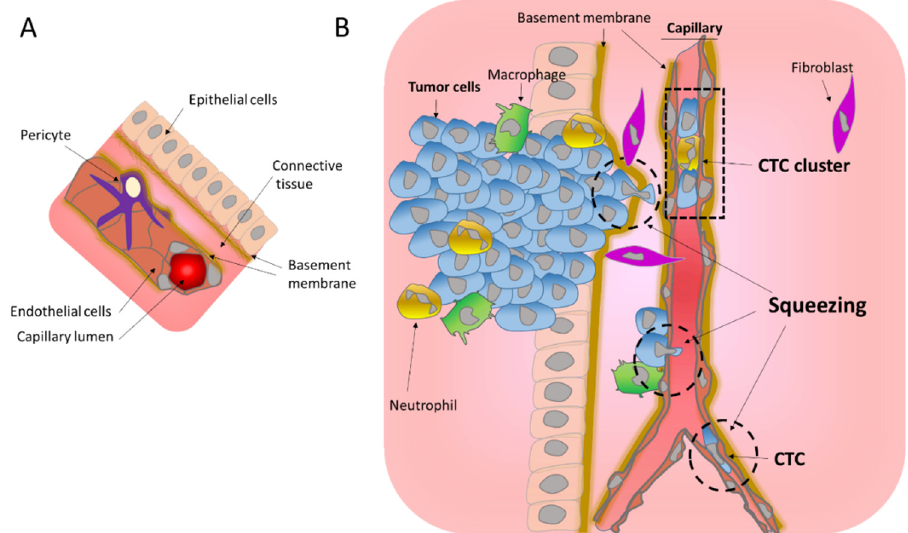
Figure 1. Mechanical challenges affecting tumor cells during migration. ( A ) Schematic representation of a normal blood vessel within its environment. ( B ) Intravasation of tumors cells into the circulation. Invading tumor cells cross the basement membrane and migrate through the connective tissue to reach the endothelial wall, which they cross to enter in the blood stream. All these steps involve important squeezing of the cells and their nuclei (hatched circle) imposing mechanical challenges. Tumor cells in the blood stream can be found as single Circulating Tumor Cells (CTC) or as CTC clusters.